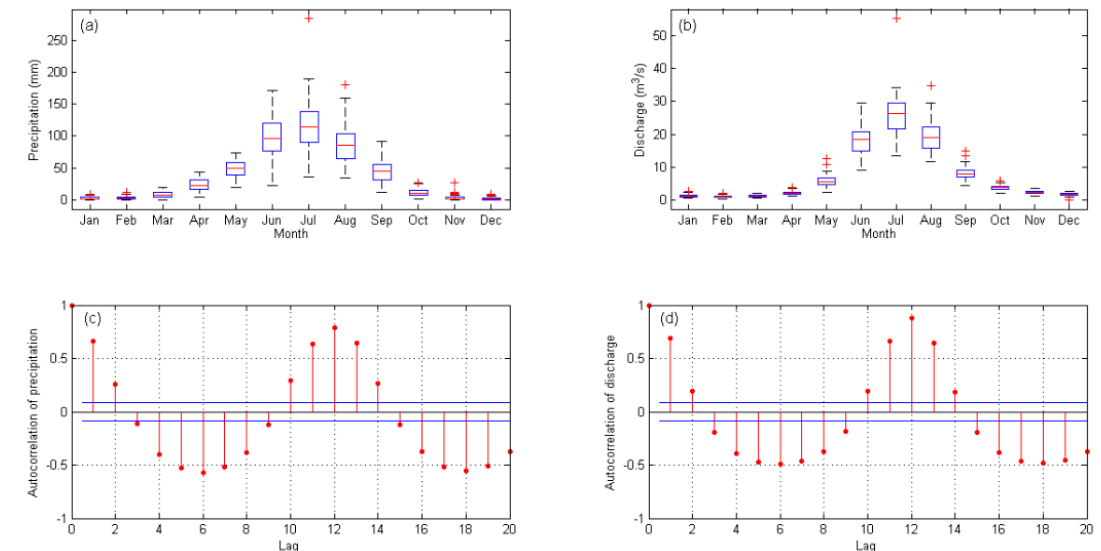
Figure 3. The boxplots of precipitation and discharge for each month and their autocorrelation functions with lags 1 to 20. ( a ) Boxplot of precipitation, ( b ) boxplot of discharge, ( c ) autocorrelation function of precipitation, ( d ) autocorrelation function of discharge.